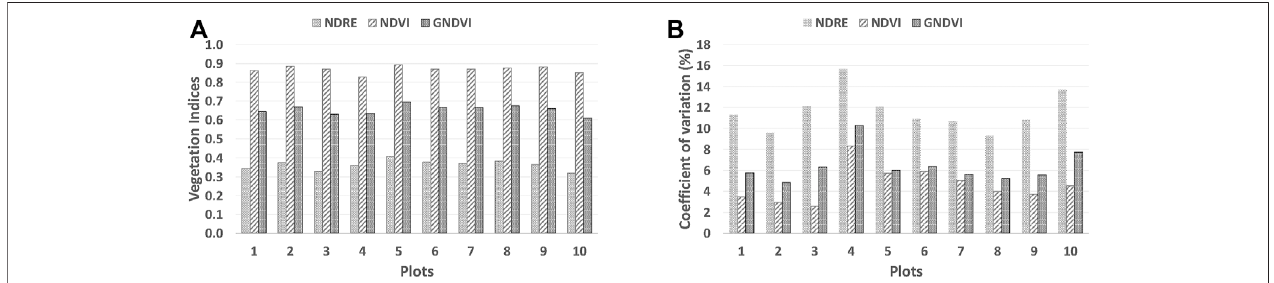
FIGURE 6 | Vegetation indices NDVI, GNDVI, and NDRE, for the selected rice fi elds (Quinta do Canal): (A) average values, and (B) coef fi cient ofvariation. The data are for July 9, 2020, from UAS images, at 0.074 m resolution.